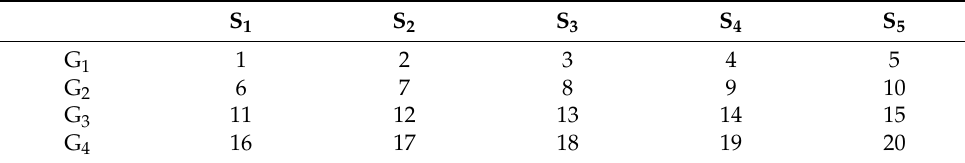
Table 3. Representation of an